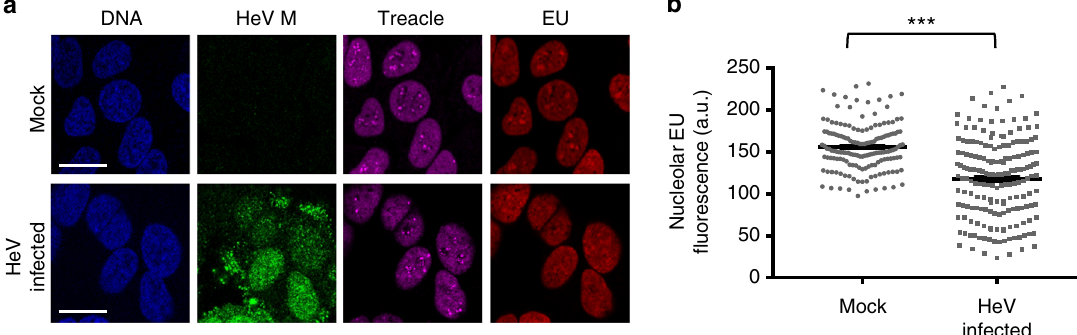
Fig. 6 rRNA production is inhibited in HeV infected cells. a HeLa cells were mock- or HeV-infected for 23 h before incubation with EU (1 h), fi xation and processing to label nascent RNA, as described in Materials and Methods. Cells were then labeled using antibodies to HeV M and Treacle proteins, and Hoechst 33342 (DNA) and then imaged by CLSM. Scale bars correspond to 15 μ m. b Images such as those in a were analyzed to quantify rRNA production (histogram shows mean nucleolar EU fl uorescence; ≥ 156 nucleoli analyzed for each condition over two biological replicates). Statistical analysis used Student ’ s t -test; ***, p <